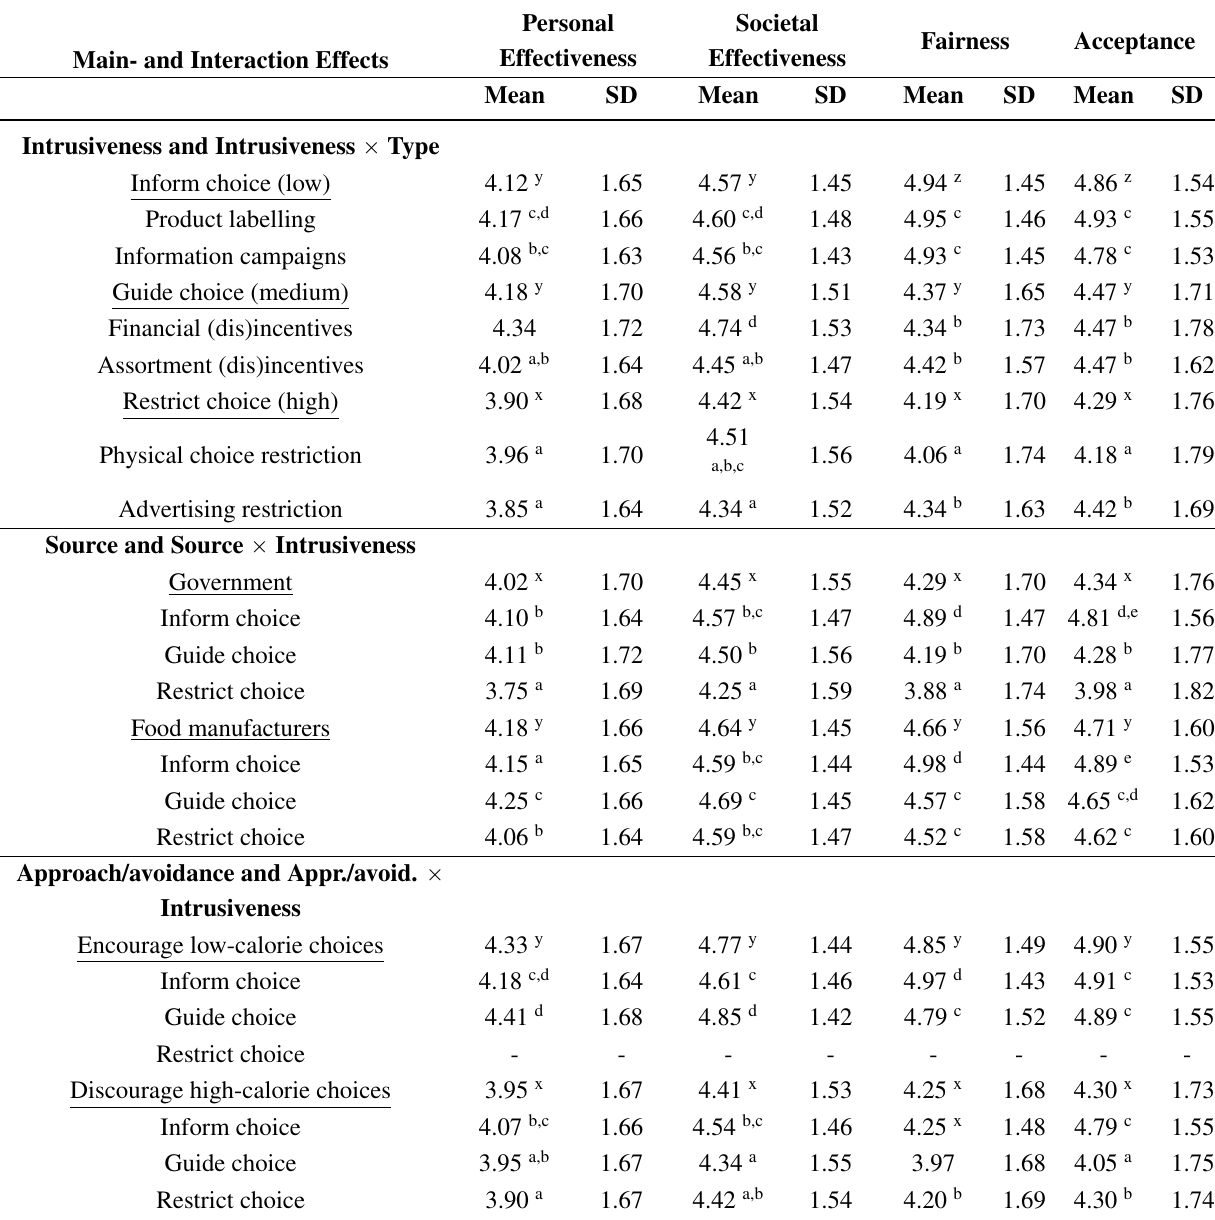
Table 5. Means of the effect sizes (partial η 2 > 0.015) for beverage interventions. Main- and Interaction